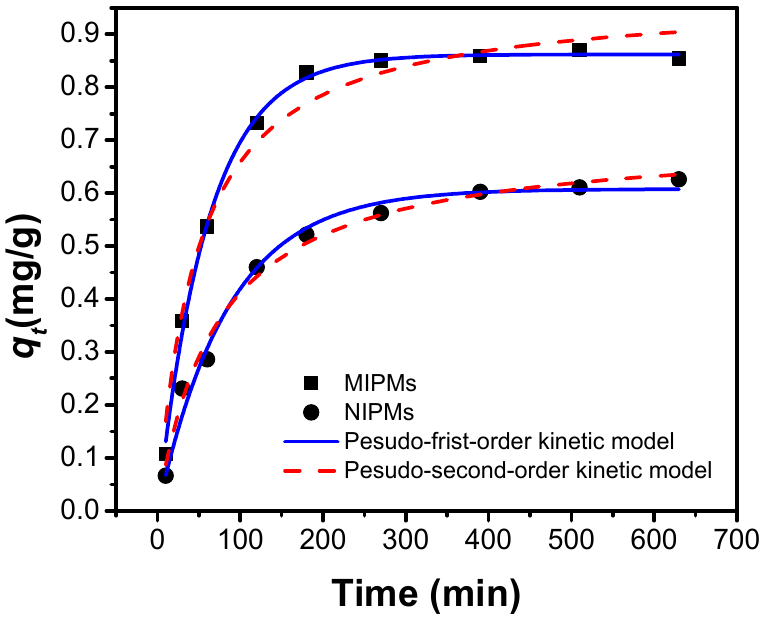
Figure 7. Adsorption kinetics for the uptake of clenbuterol onto the NIPM and MIPM adsorbents, together with the data fitting based on pseudo-first-order and pseudo-second-order kinetic models.